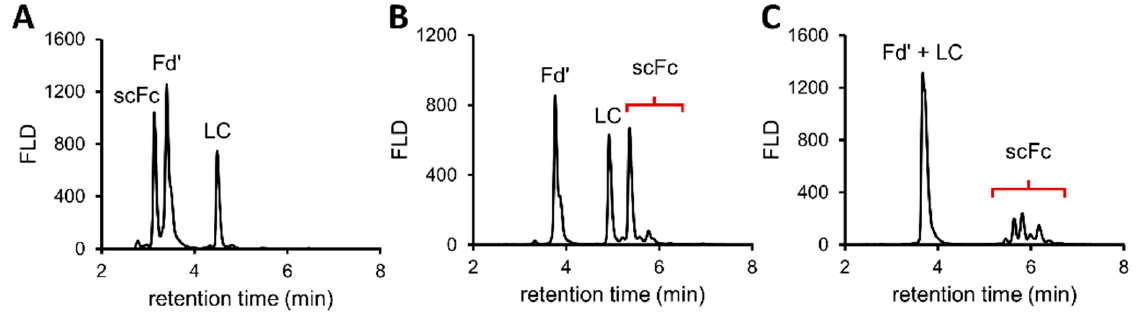
Figure 4. Middle-up HILIC-MS analysis of IdeS digested and DTT reduced atezolizumab ( A ), benralizumab ( B ) and obinutuzumab ( C ). FLD chromatograms display the separation of the Fd’, LC and scFc subunits. See Tables S2 and S3 for detailed retention times and mass assignments.